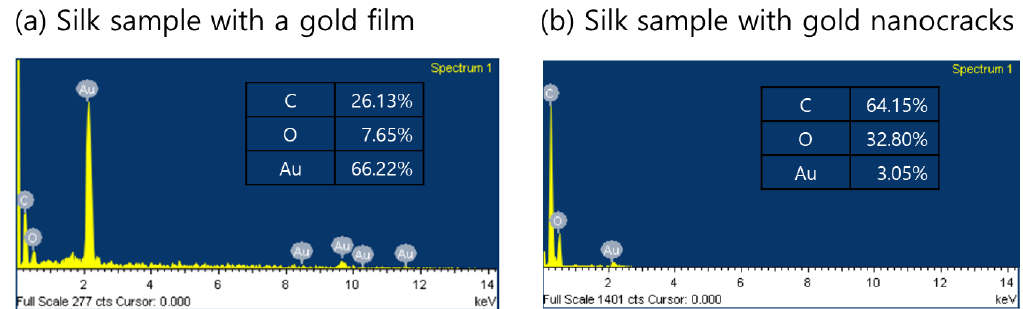
Figure 6. Energy-dispersive X-ray spectroscopy measurements. Percentage weight of contents for ( a ) porous silk-based SERS sensor with a 40 nm thick gold film and ( b ) porous silk-based SERS sensor with a 3 nm thick gold nanocracks.